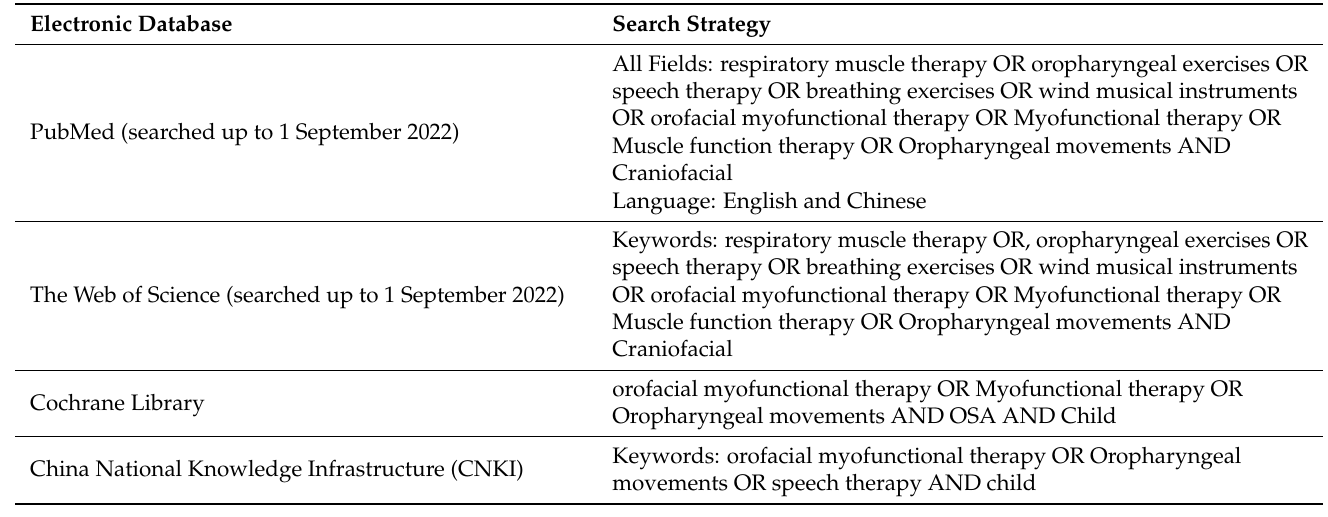
Table 1. Electronic database search strategies.